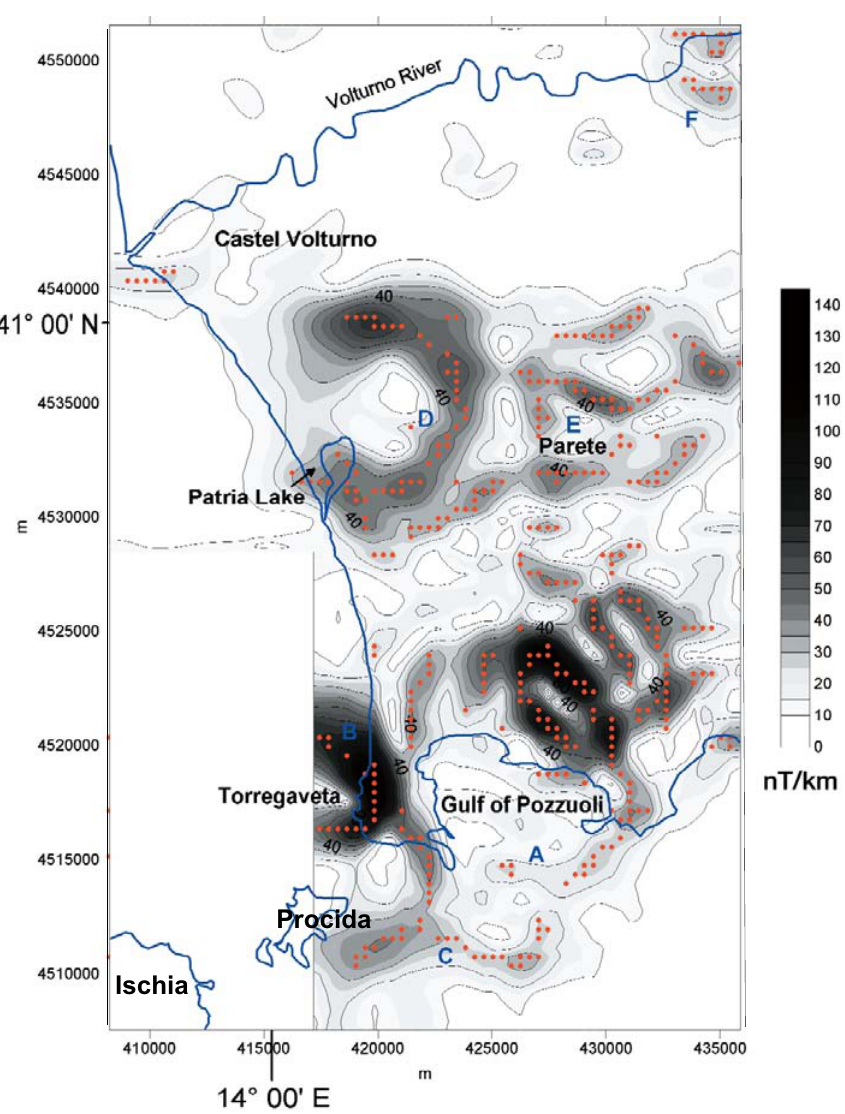
Figure 11. Map of the horizontal derivative plotted in the gray scale of the southern Volturno Plain (reported from Paoletti et al. [2004]). The letters A-F indicate the main magnetic anomalies recognized in the area (see main